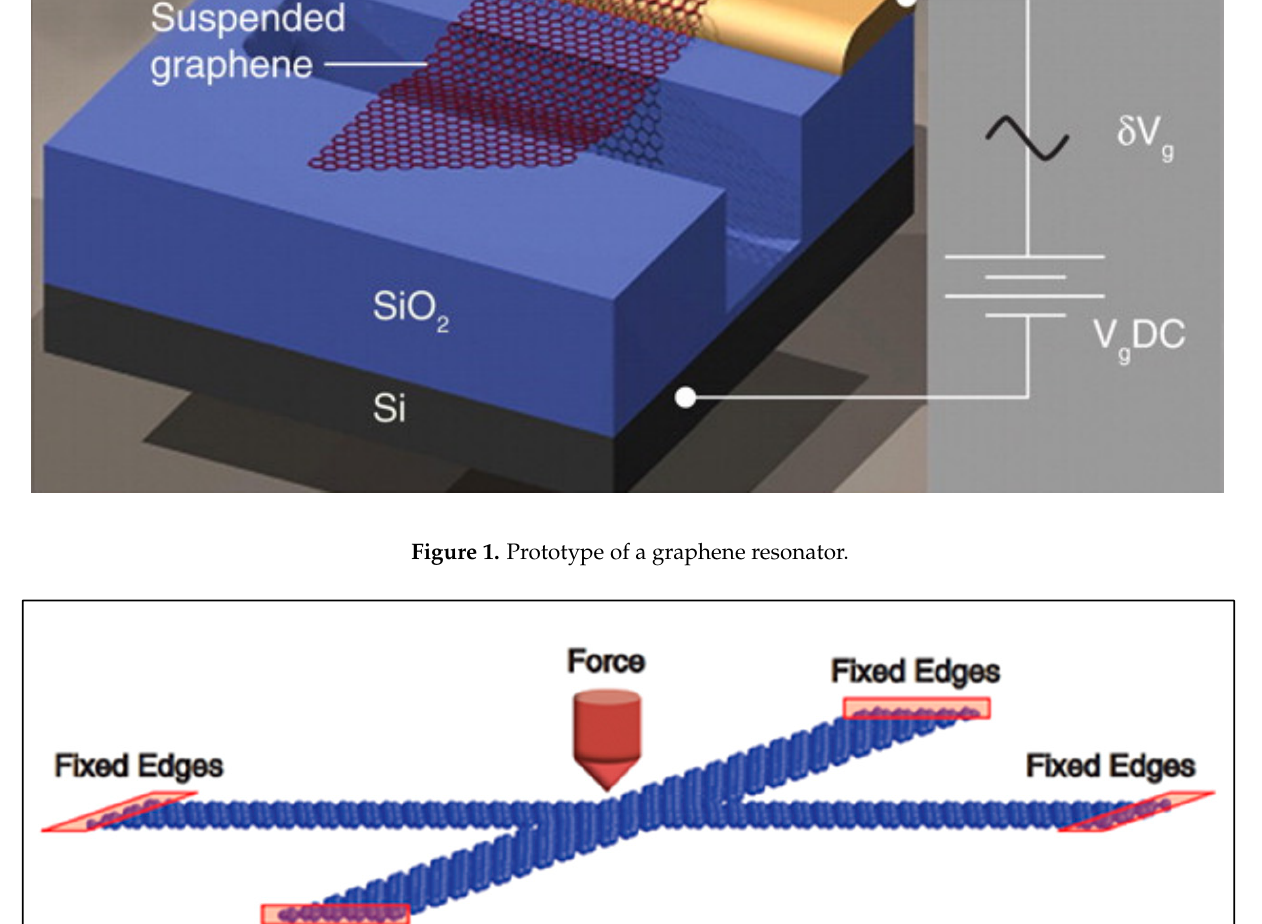
Figure 2. Accelerometer based on suspended cross-type graphene resonator.